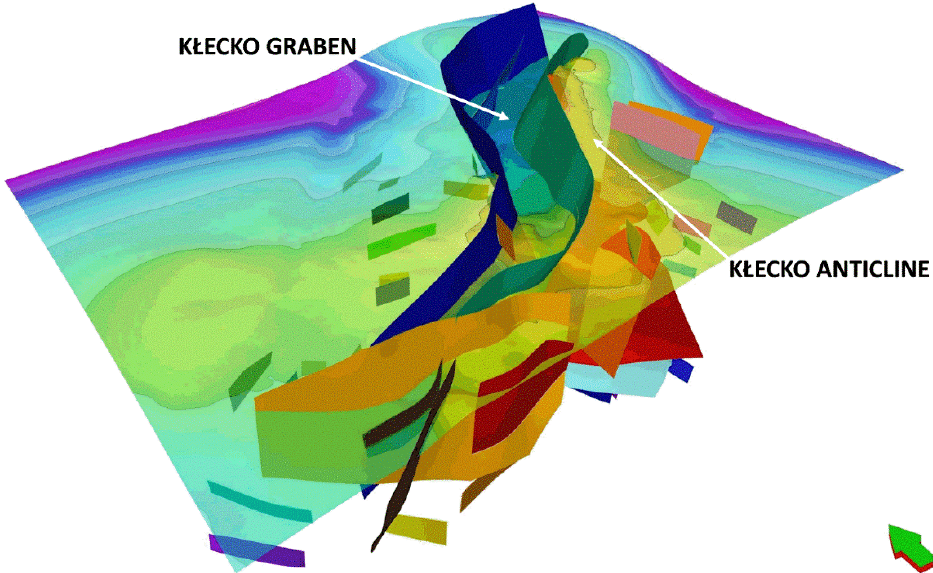
Figure 10. Spatial diagram of the tectonic variability at the background of the top Middle Jurassic surface (SMV2).